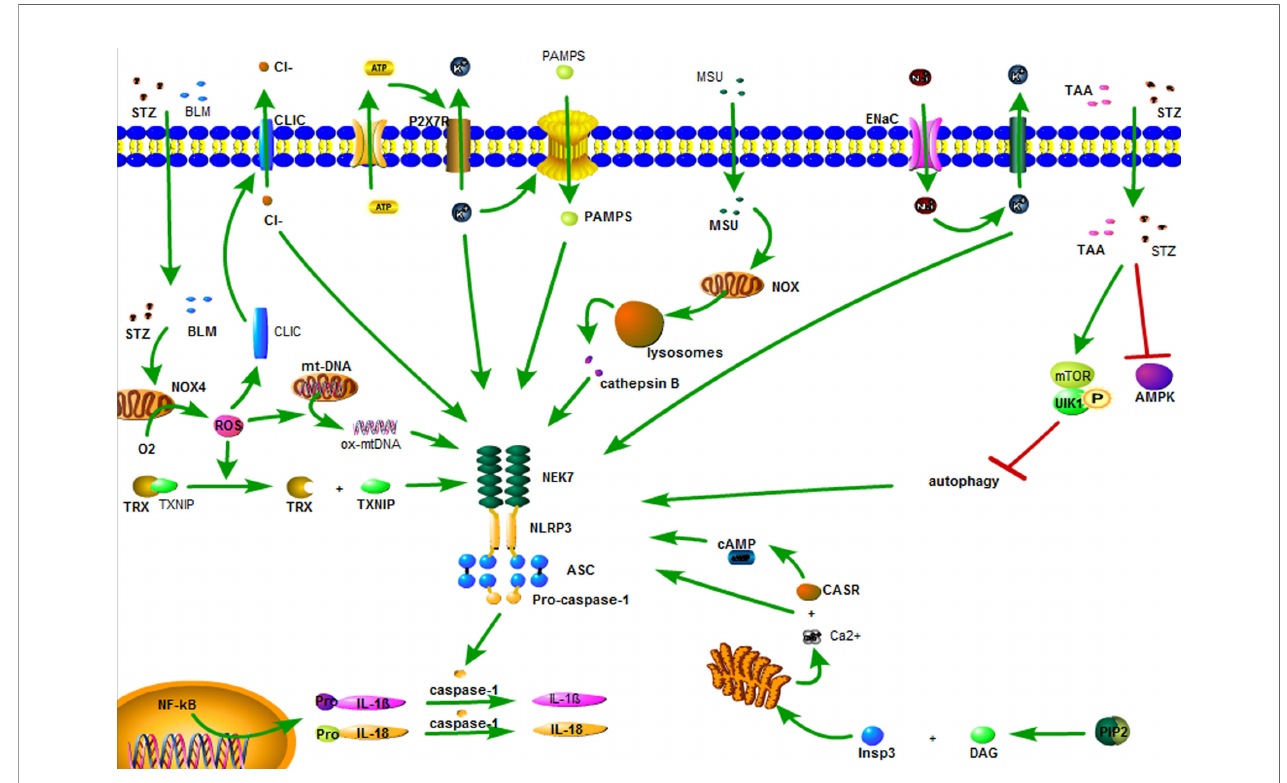
FIGURE 2 | The activation of the NLRP3 in fl ammasome. ATP recognizes P2X7 purinergic receptor (P2X7R) on the cell membrane, opens the ion channel, and leads to K + out fl ow, recruiting ubiquitinated connexin to punch holes in the cell membrane. The PAMPs enters the cells and promotes the binding of the catalytic domain of NIMA-related kinase 7 (NEK7) to NLRP3 and activates NLRP3 in fl ammasome. Streptozotocin (STZ), bleomycin (BLM) and statins fi rst damage mitochondria, and then activate NADPH oxidase 4 (NOX4), leading to ROS activation. ROS induces dissociation of thioredoxin and thioredoxin interacting protein (TXNIP). TXNIP directly activates NLRP3 in fl ammasome. In addition, ROS also induces the conversion of mitochondrial DNA (mtDNA) into oxidized form (ox-mtDNA), which, as the ligand of NLRP3, directly binds and activates NLRP3, activating NLRP3 in fl ammasome. The crystals/macromolecules, such as monosodium urate (MSU) activates NADPH oxidase through chemical reaponse, which damages the lysosome, releasing cathepsin B, activating NLRP3 in fl ammasome. Epithelial sodium channels (ENaC) on the surface of the cell membrane are opened to allow Na + in fl ow, leading to K + out fl ow, and activating the NLRP3 in fl ammasome. Chloride intracellular channels (CLIC) act as the downstream of the K + out fl ow-mitochondrial ROS axis. ROS induces the transfer of CLIC to the cell membrane, leading to Cl - out fl ow. The out fl ow of Cl - enables NEK7 to bind to NLRP3 and promotes the assembly and activation of NLRP3 in fl ammasome. Phospholipase C hydrolyzes phosphatidylinositol-4,5-diphosphate to form diacyl glycerol (DAG) and inositol trisphosphate (InsP3). InsP3 binds to the InsP3 receptor on the endoplasmic reticulum membrane, causing the endoplasmic reticulum to release Ca 2+ , resulting in an increase in intracellular Ca 2+ . Ca 2+ is recognized by calcium-sensing receptor (CASR) and activates NLRP3 in fl ammasome. STZ cooperates with thioacetamide (TAA) through adenosine monophosphate-activated protein kinase (AMPK)/mammalian target of rapamycin (mTOR) pathway inhibition autophagy effect, leading to activation of NLRP3 in fl ammasome. CASR leads to a decrease in intracellular cAMP, weakens the binding capacity of cAMP and NLRP3, and activates NLRP3 in fl